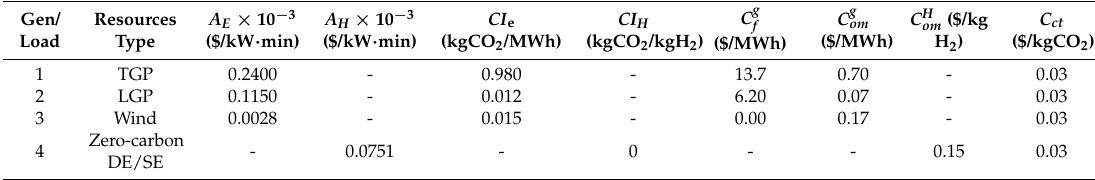
Table A2. Parameters used for units and